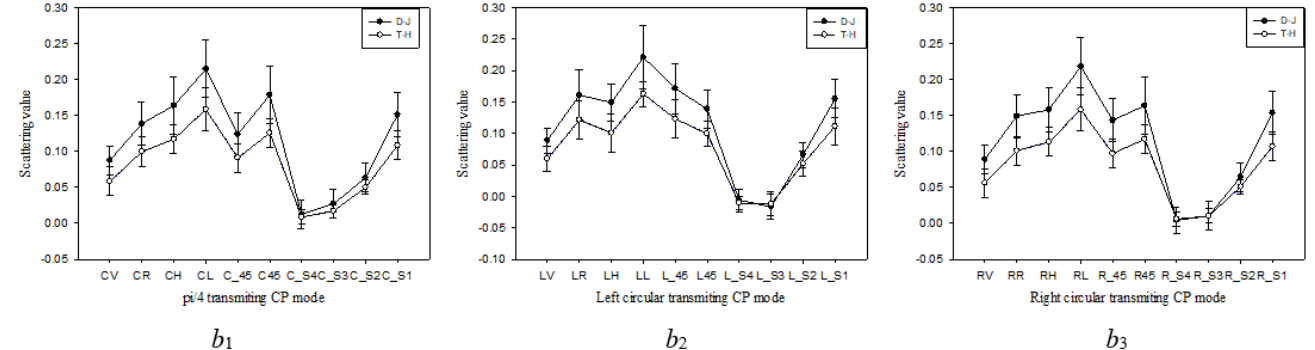
Figure 5. The CP parameters line diagram of the two types of rice under three transmitting modes (( b 1 ): π /4 transmitting mode; ( b 2 ): left circular transmitting; ( b 3 ): right circular transmitting) on 30 July 2015 (0730 period).